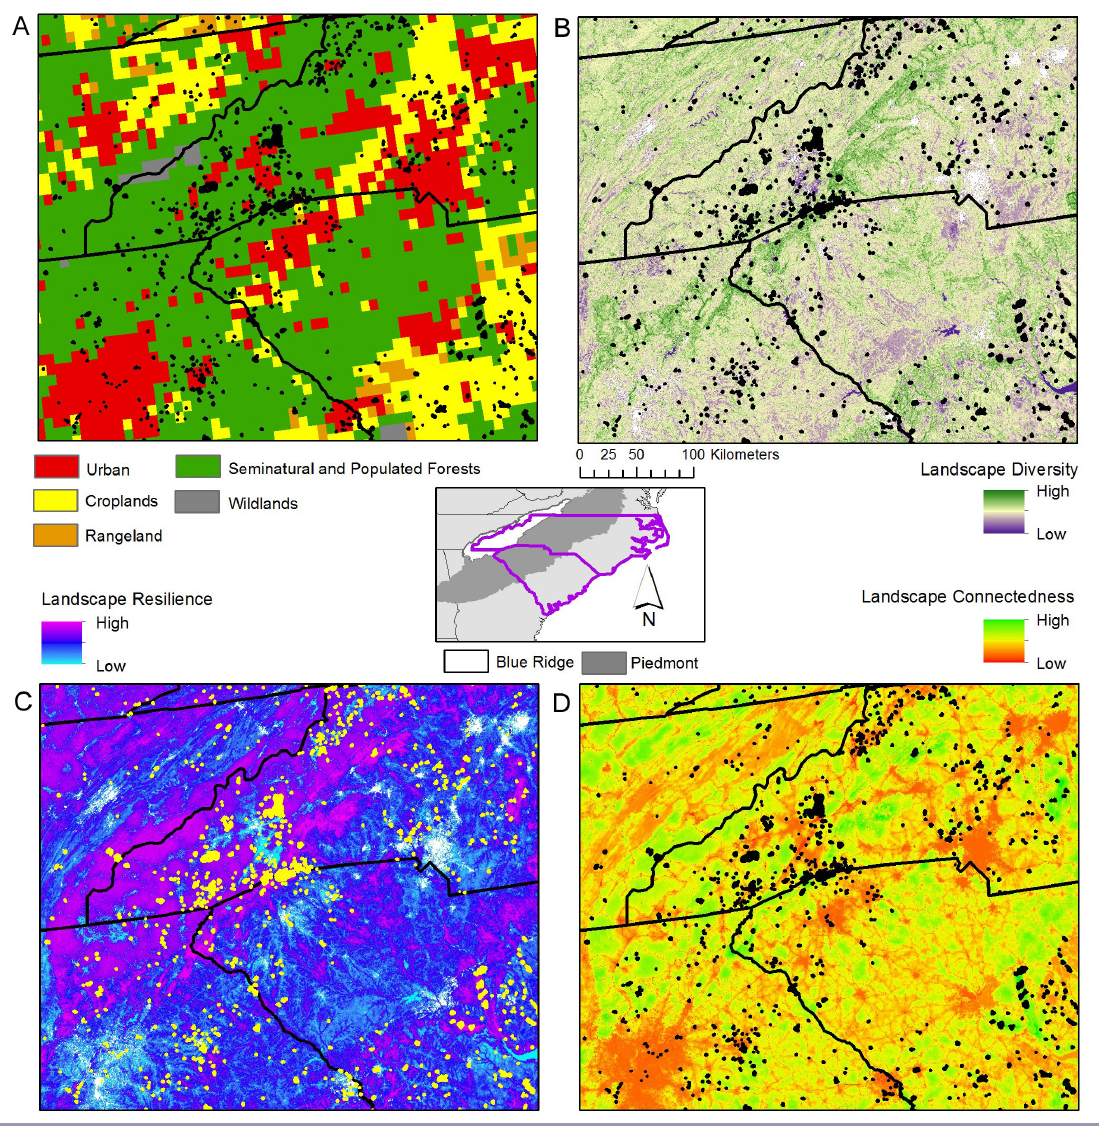
Fig. 3 . Distribution of conservation easements (black outline) in the Southern Piedmont and Blue Ridge regions of North and South Carolina across (A) anthrome types (Ellis et al. 2010), (B) landscape diversity, (C) landscape resilience, and (D) landscape connectedness (Anderson et al.